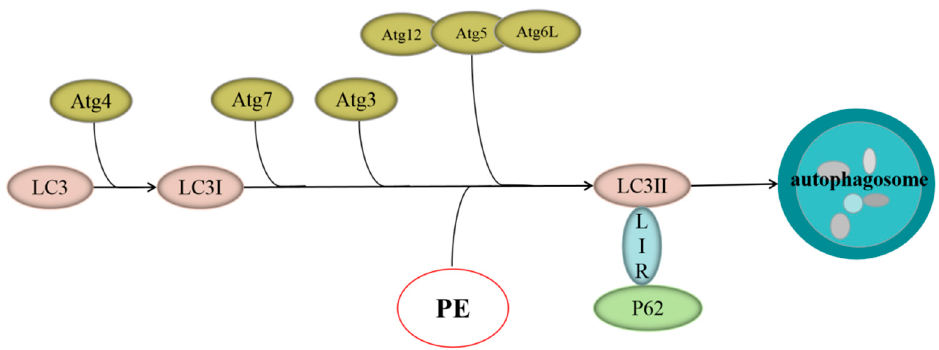
Figure 1. Microtubule-associated protein 1 light chain 3 (LC3)-P62 autophagy signaling pathway.